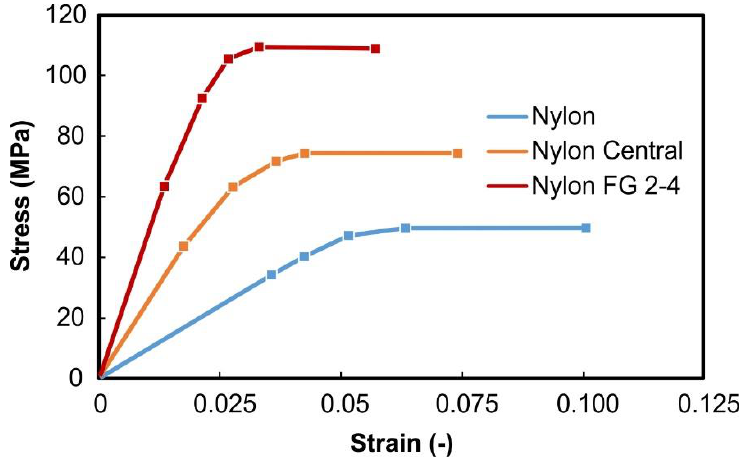
Figure 11. FEM-determined stress-strain curves of Nylon, Nylon FG central and Nylon FG, top 2–4 positions.